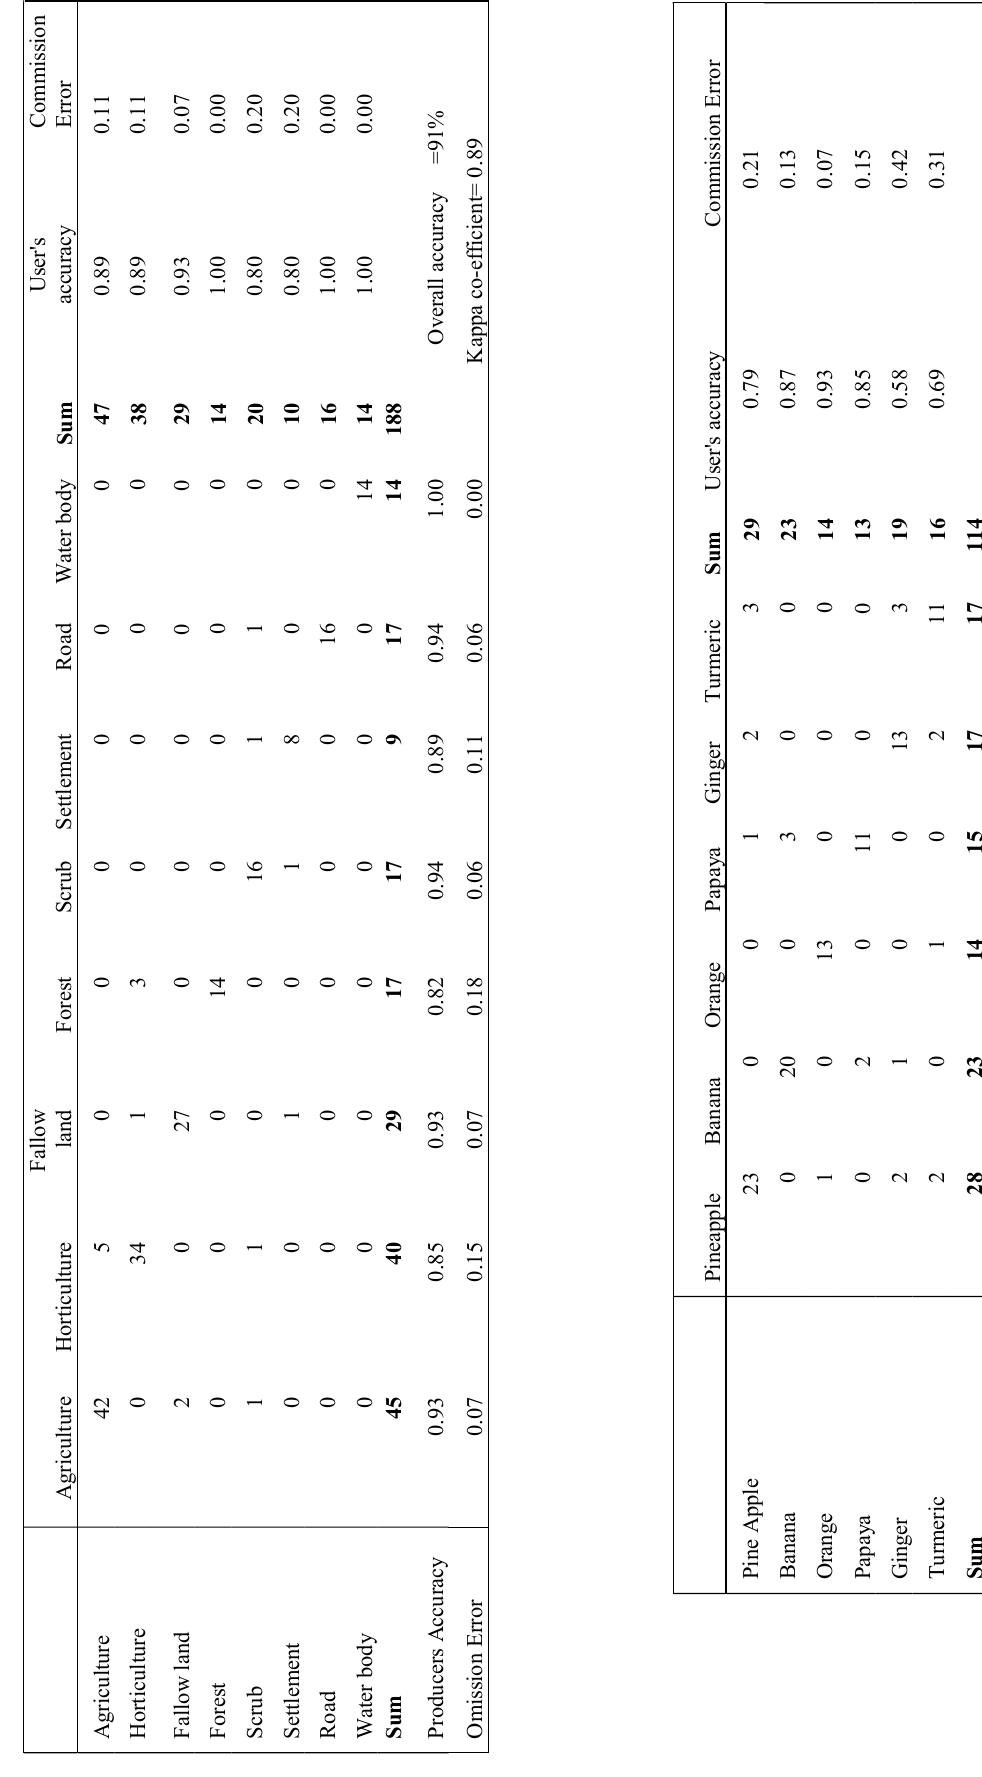
Table 4. Confusion matrix for Level-1 classification (Land cover classes)